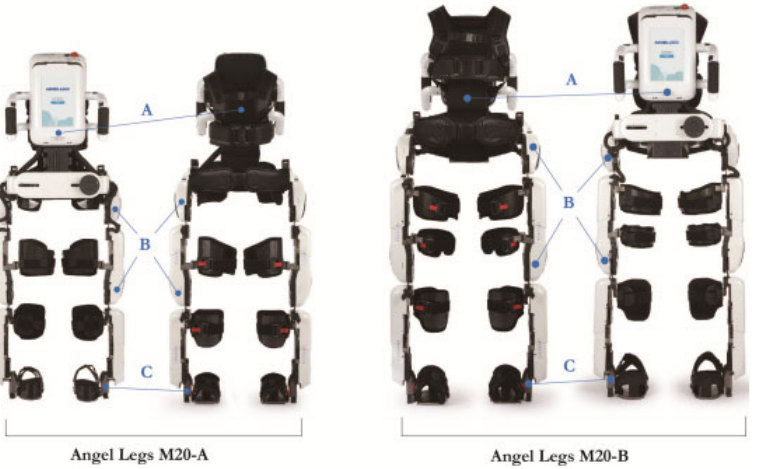
Figure 1. Joint-torque-assisting Wearable exoskeletal robot. The Angel Legs-M20 consists of a child-sized model (the M20-A) and an adult-sized model (the M20-B): A: a controller backpack that includes a battery and inertial measurement unit sensor in the backpack circuit for analyzing trunk tilt angle; B: hip and knee joint actuator to guide walking posture by generating energy as well as an incremental encoder for joint angular velocity measurement installed in the actuator motor circuit and an absolute encoder to measure the absolute joint angle in the output shaft of the actuator; C: ground contact sensor at the lateral side of the foot support.